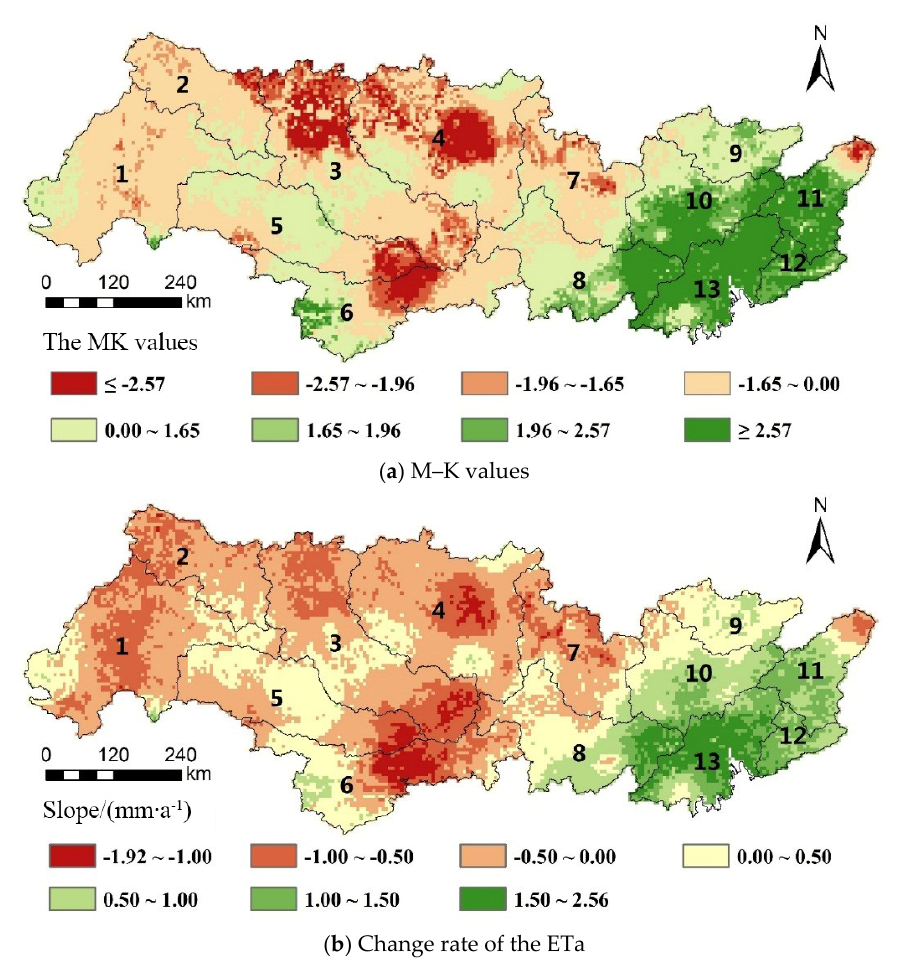
Figure 6. Spatial distribution of the trends of the annual ETa identified by the M–K test. ( a ) M–K values; ( b ) Change rate of the ETa. The name of the sub-regions refers to those in Figure